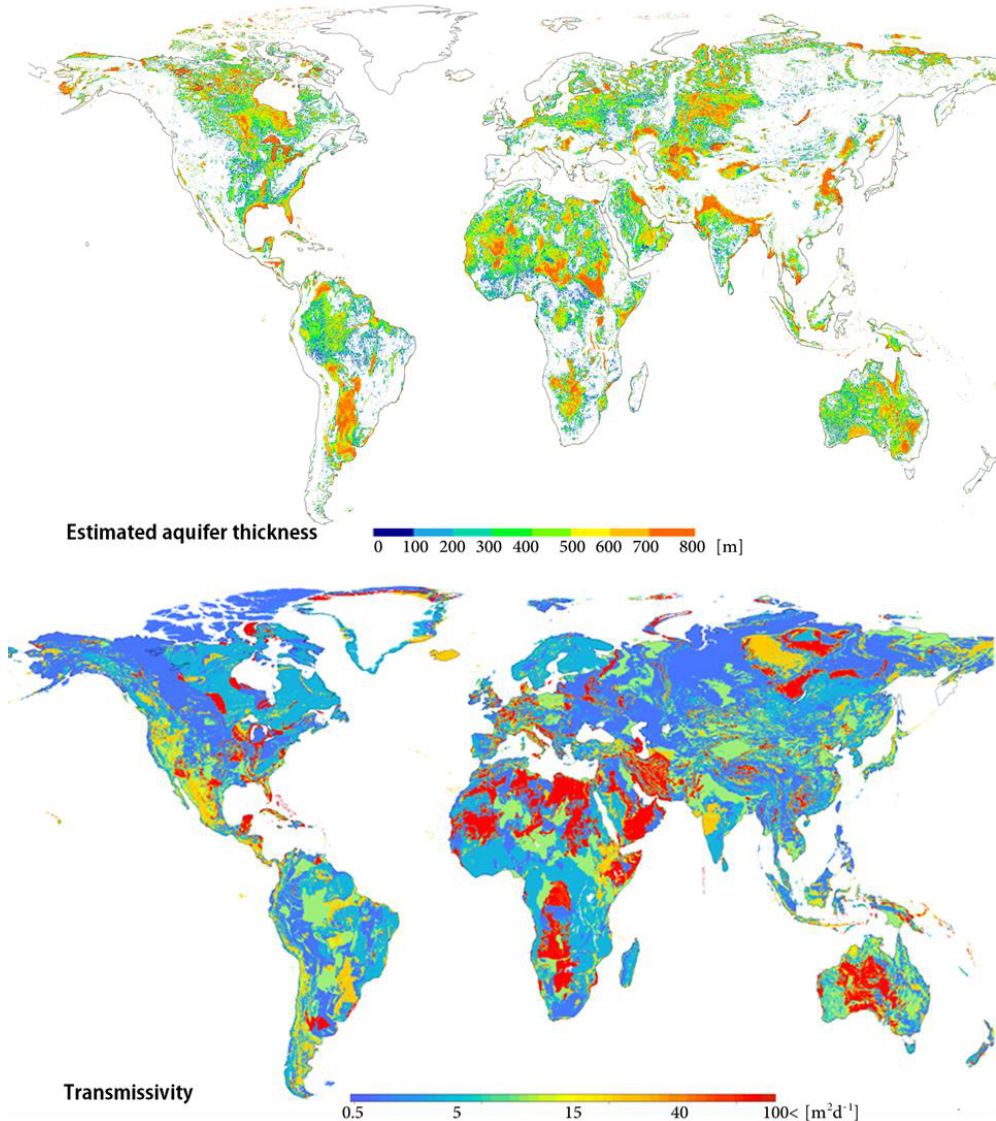
Figure 3. Calculated aquifer thicknesses and